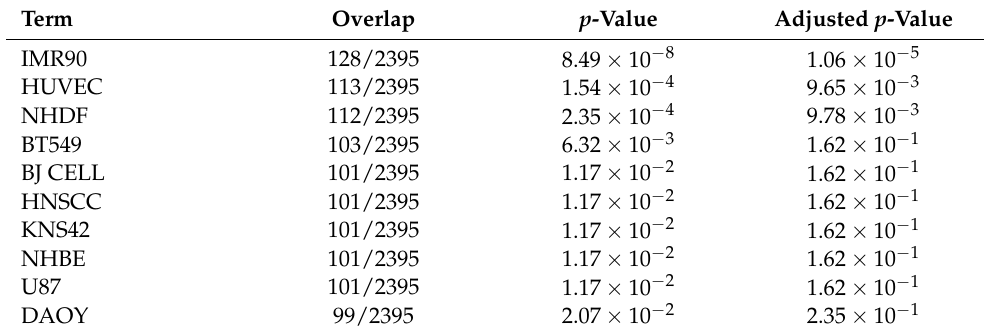
Table 10. The top 10 enriched terms in “ARCHS4 Cell-lines” using Enrichr. Overlap is the number of common genes between the genes uploaded and the genes in the category divided by the number of genes in the category. Probes, whose associated genes were uploaded to Enrichr, were identified using linear regression.